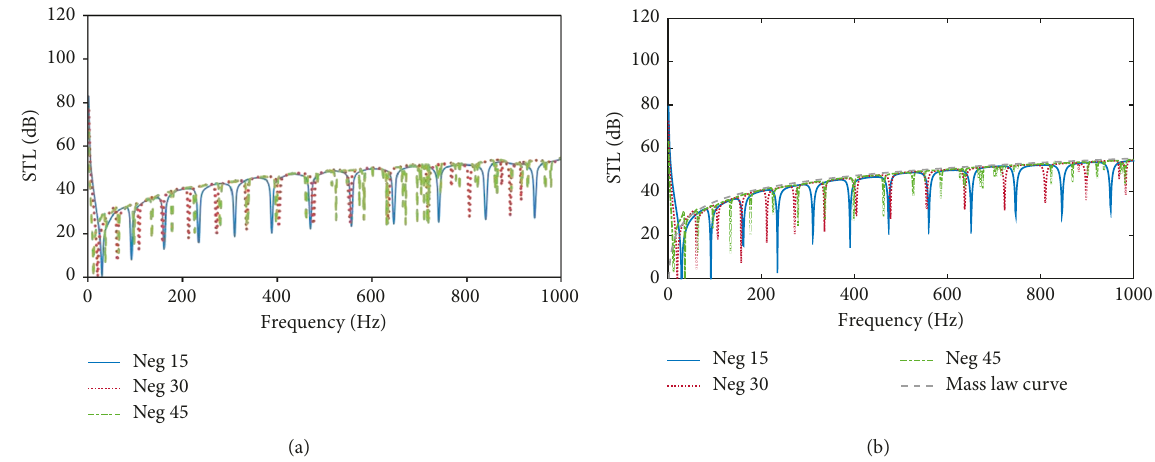
Figure 12: The calculated STLs of the sandwich panels for verification by comparing (a) Figure 11 in [18] and (b) the calculated STLs via the proposed method with the structural damping factor η �